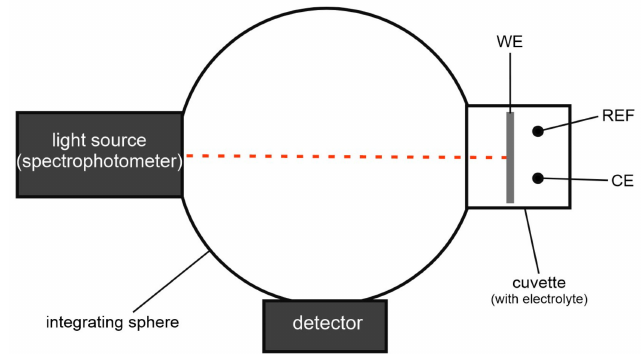
Figure 1. Spectroelectrochemical measurement set up with a three-electrode cell (WE—working electrode, REF—reference electrode, CE—counter